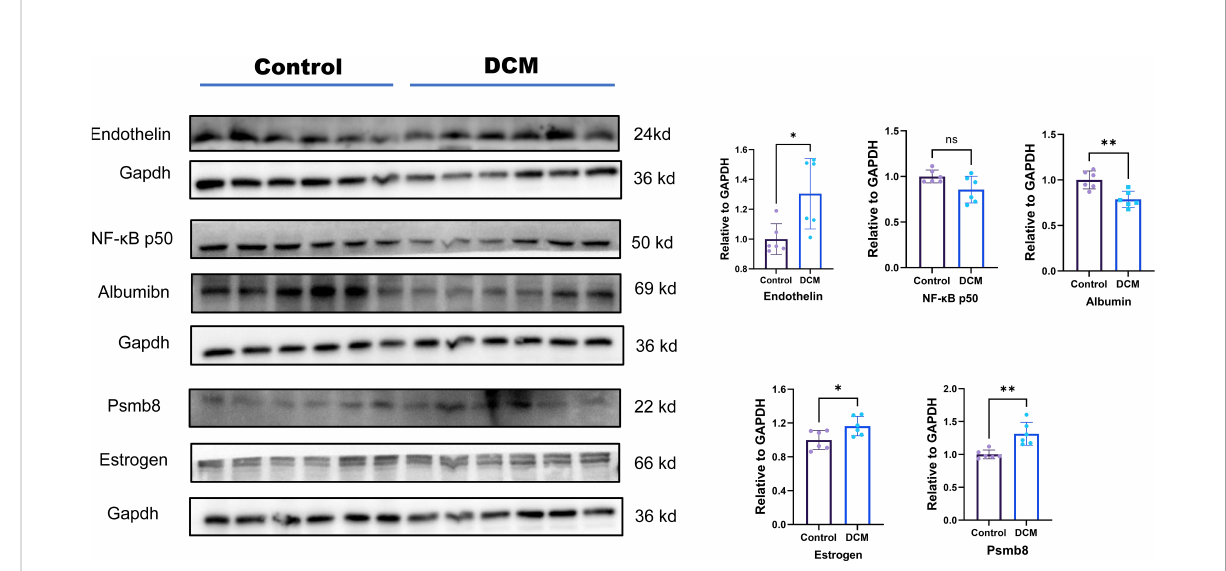
FIGURE 8 Protein level expression of hub genes. Ns means p value >0.05;* means p value <0.05; ** means p value <0.01; *** means p value